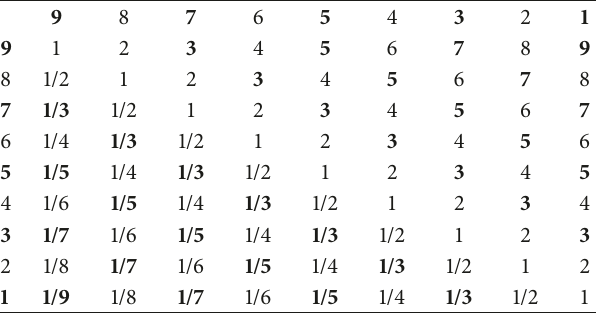
Table 5: Criteria for comparing assessments of the demand for CR5 criteria from the uses for automation of